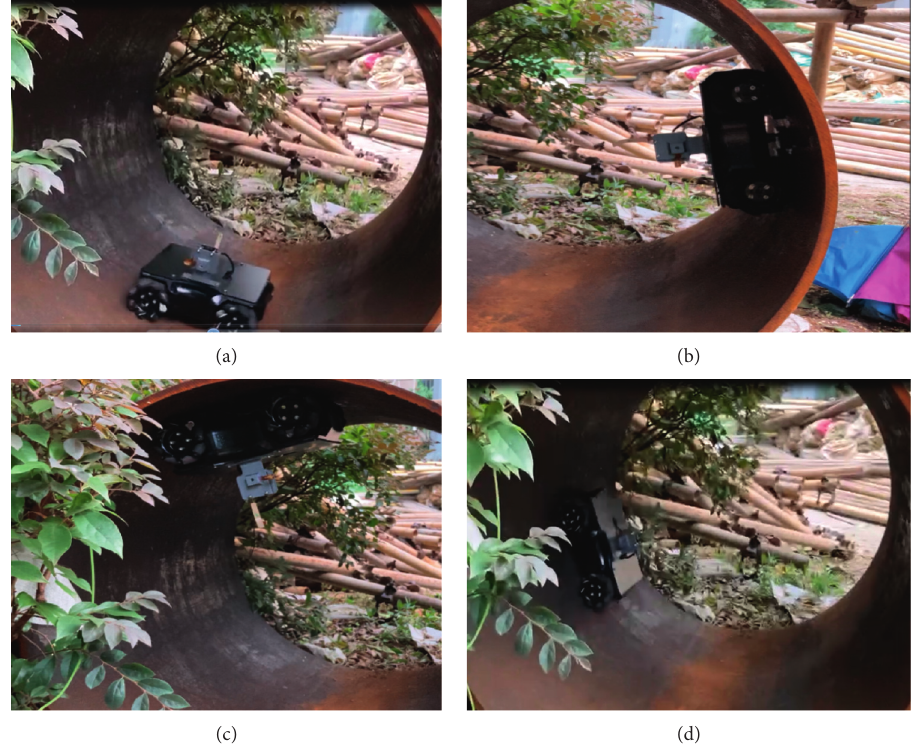
Figure 13: GIS inspection robot climbing performance experiment in simulated environment. (a) Horizontal (initial state), (b) right vertical wall, (c) left vertical wall, and (d) return to initial state.